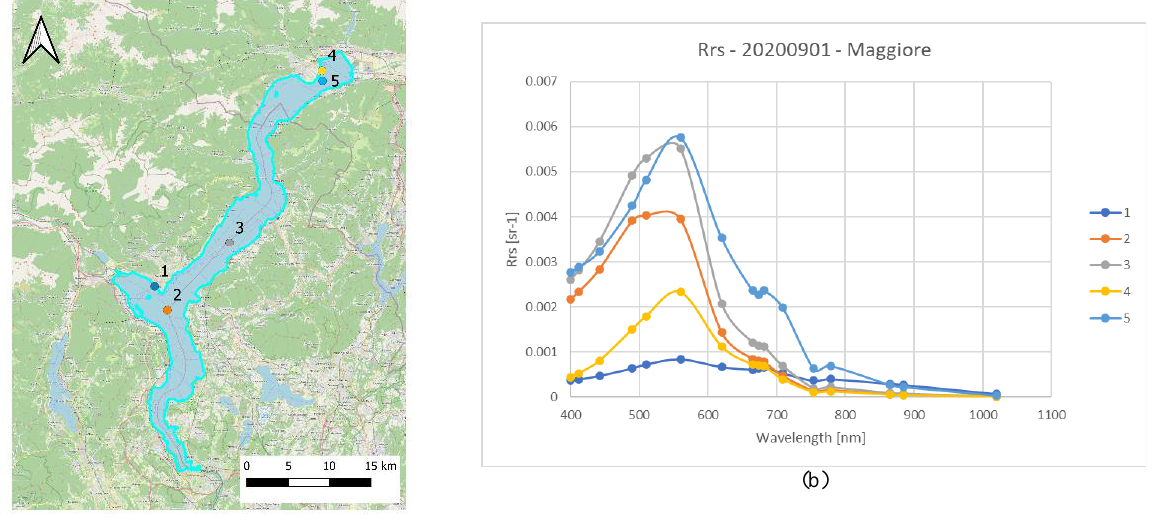
Figure 7 . Graph (b) shows the spectral signatures of the sampling points distributed on the lake